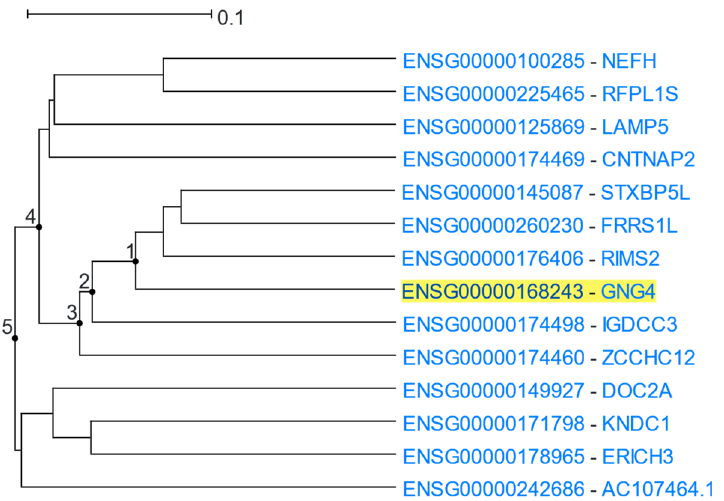
Figure 1. The five branching points (depicted as numbered dots), from the driver gene leaf ( GNG4 ) until the root of the clade, constitute the internal nodes of this coexpression clade.